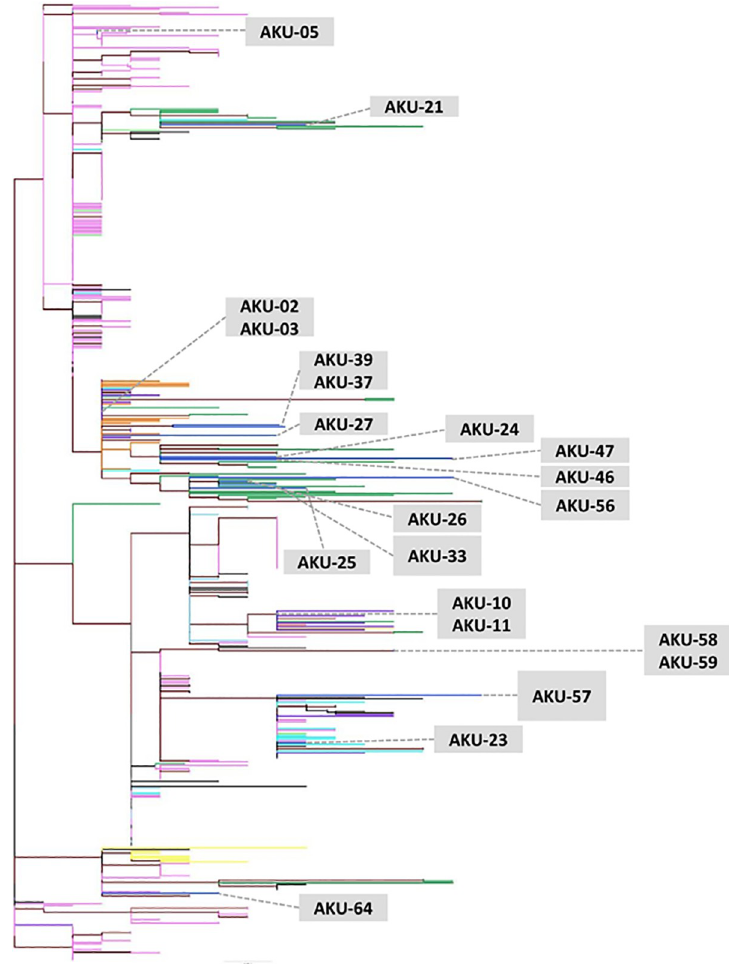
Fig 1. Maximum-Likelihood phylogenetic tree of SARS-CoV-2 sequences from Karachi. The tree was constructed using 21 genomes from this study (AKU) (S2 Table) along with 58 other Pakistani and 449 full-length SARS-CoV-2 reference sequences (S1 File). AKU study sequences are indicated in blue, while other Pakistan sequences are shown in green. AKU sequences clustered with those from India (purple), Saudi Arabia (orange), United States (pink), China (light blue), Australia (turquoise), Bangladesh (yellow), France (light green) and also with other sequences from Pakistan (green). The root of the tree was determined using TreeRate tool by applying generalized midpoint rooting strategy. Nodes with significant ( > 0.90) aLRT-SH like support values are colored maroon. The tree was visualized and edited in Figtree